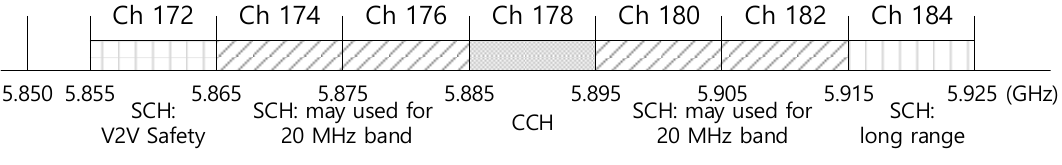
Figure 1. The 5.9 GHz channel allocation in the US.